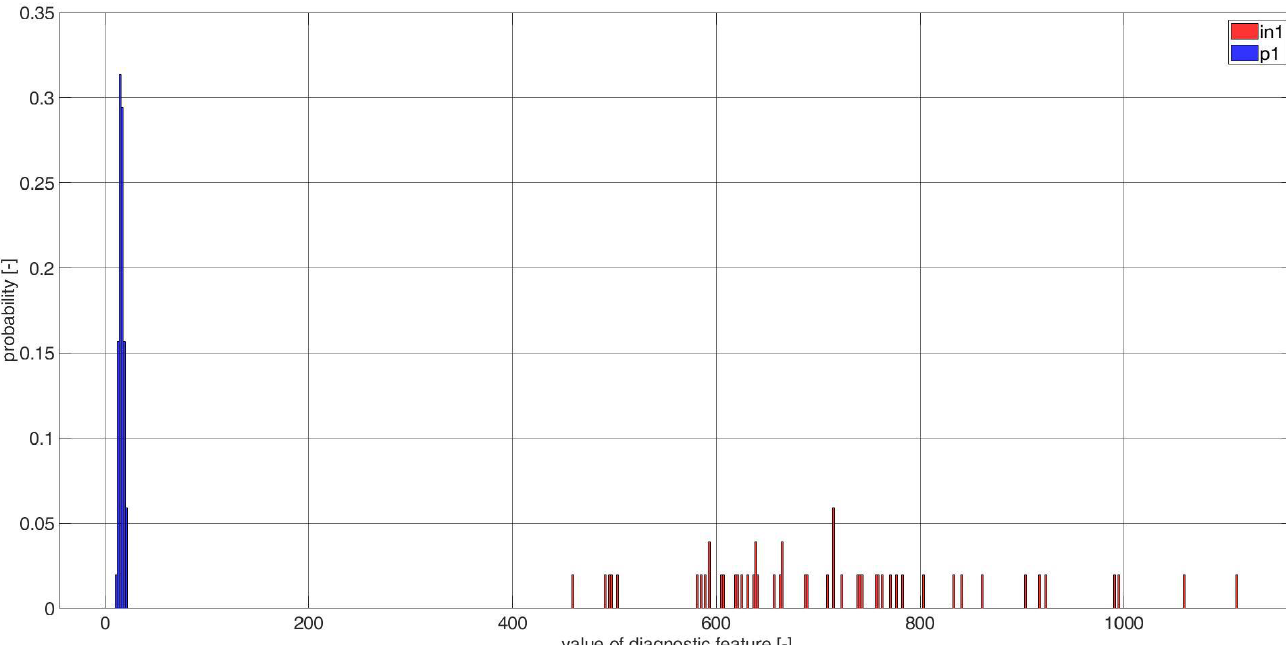
Figure A22. Histograms of diagnostic features based on the CCSM3 (correlation number is 22 — Table A1) bearings in2 and p2.